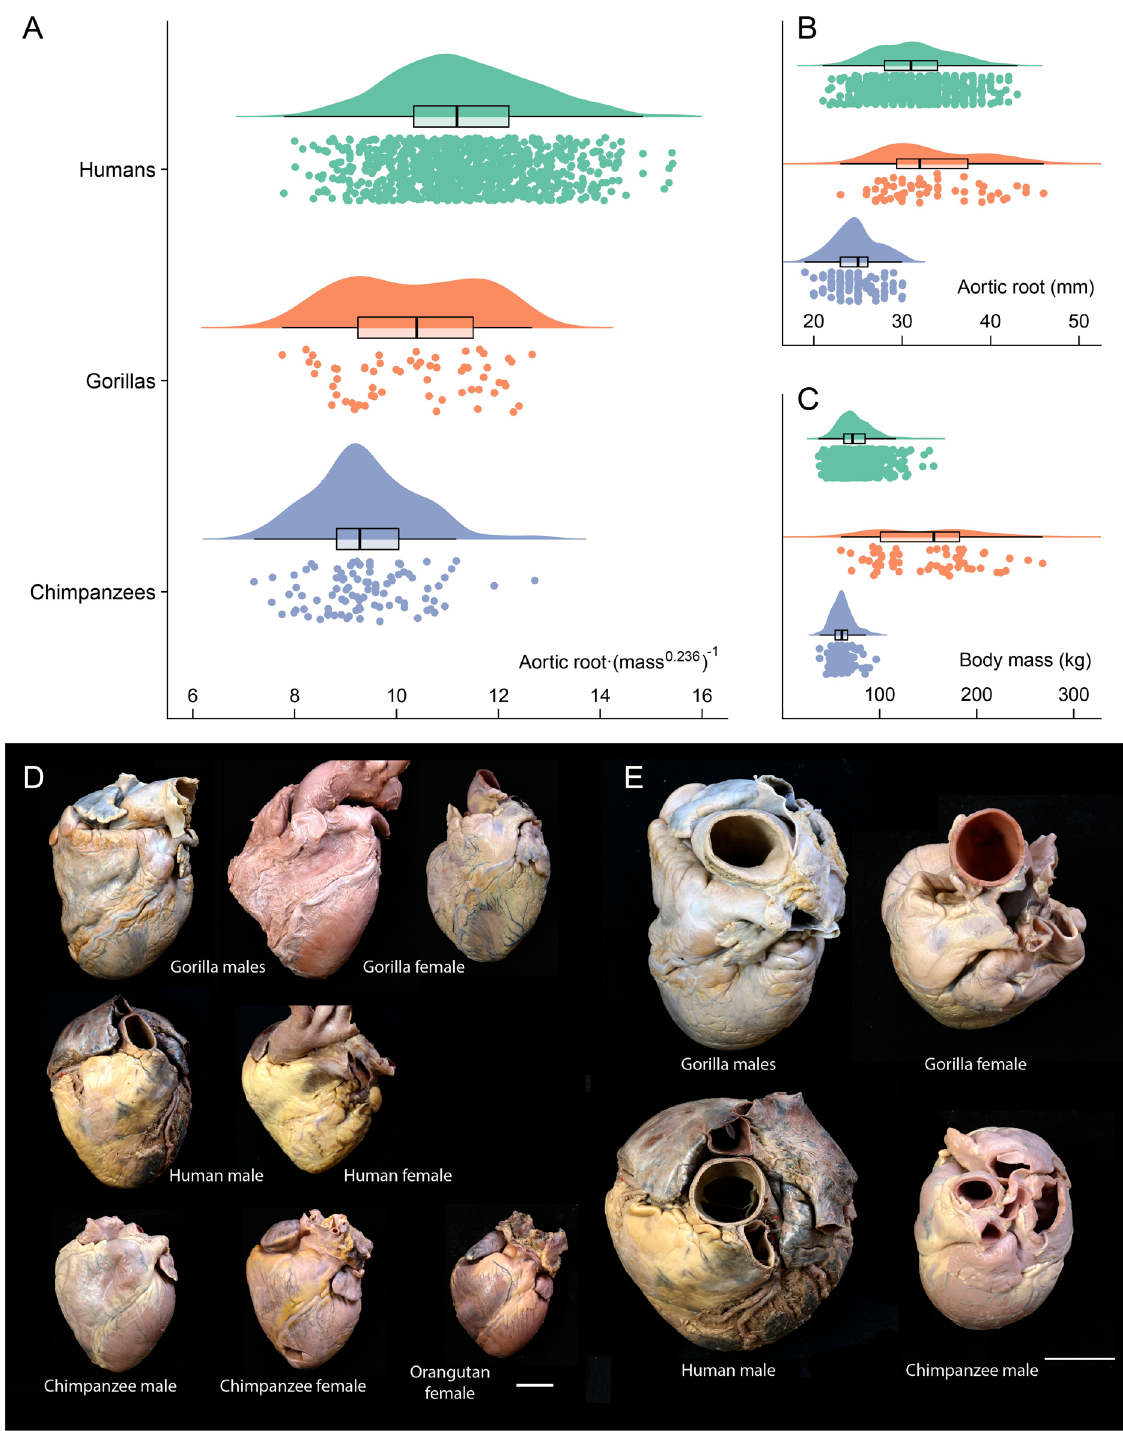
Figure 1. Differences between humans, gorillas, and chimpanzees (sexes combined), in aortic root diameter scaled to body mass raised to the exponent 0.236 ( A ), aortic root diameter ( B ), and body mass ( C ) (see Supplementary Materials 2–4). The raw data and probability density, together with a box plot (median and interquantile range), are shown in these raincloud plots 77 . All comparisons between species were statistically significant ( P < 0.001), except for the aortic root diameter between humans and gorillas ( P = 0.208). P values correspond to Games-Howell post hoc tests, corrected for family wise error (36 tests), with the Bonferroni-Holm method (see Supplementary Material 2). In ( D ), anterior view of hearts from anatomical dissections carried out by one of the authors (F.P.) for teaching purposes in the Faculty of Medicine (Valladolid, Spain) (Supplementary Material 3). From top to bottom and from left to right, two male and one female gorilla hearts (who died in different Zoological Parks in Spain); one male and one female human heart from donated bodies; one male and one female chimpanzee hearts together with a female orangutan heart (individuals who died in different Zoological Parks in Spain). In ( E ), view of the ascending aorta of selected hearts from ( D ), the gorilla male and female (top row), and a human and chimpanzee males (bottom row). White bars, 3